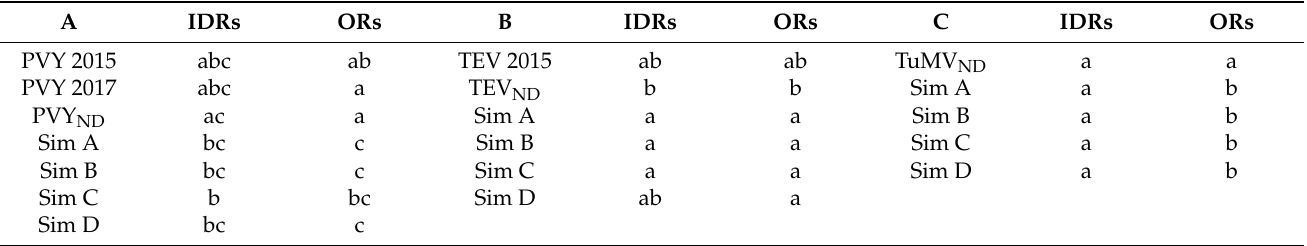
Table 3. Differences in physicochemical properties associated with amino acid substitutions were assessed using scores derived from the BLOSUM62 substitution matrix. For each type of region (IDRs or ORs), virus biological and simulated data were distributed into statistical groups (a, b, and c) by running a Dunn test ( p value adjustment method: Bonferroni) for the (A) PVY genome, (B) TEV genome, and (C) TuMV